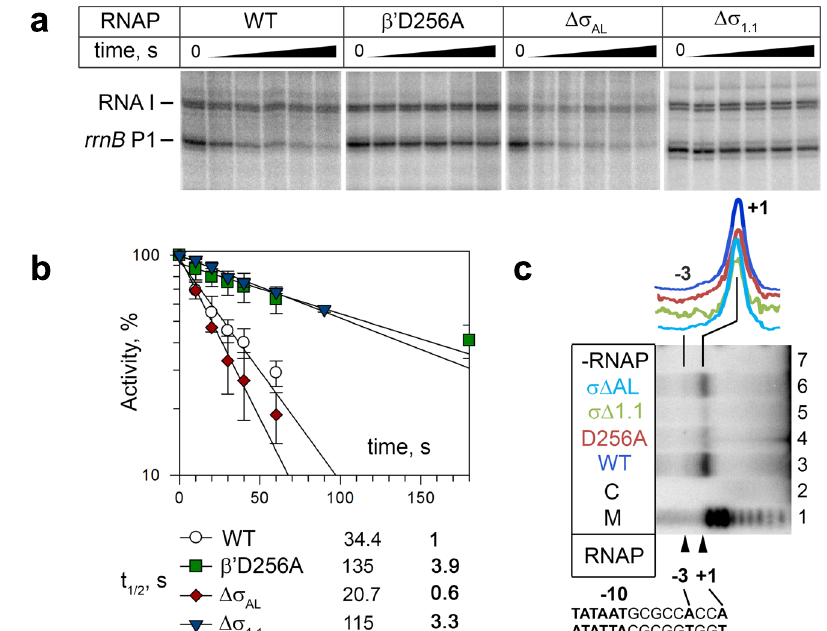
Fig. 3 Stabilities of rrnB P1 promoter complexes formed by wild-type and mutant RNAPs and their sensitivities against DksA/ppGpp. a Stabilities of rrnB P1 promoter complexes. Preformed complexes of E. coli RNAP with supercoiled plasmid DNA containing the rrnB P1 and RNAI promoters were incubated with competitor DNA (containing upstream fork-junction promoter DNA but lacking the TSS) for the indicated time intervals, followed by the addition of NTP substrates. Positions of the full-length transcripts are indicated. For each RNAP, the experiments were repeated independently two to fi ve times with similar results. b Kinetics of promoter complex dissociation for wild-type and mutant RNAPs. The half-lives of the promoter complexes for each RNAP are shown (measured in the absence of DksA; mean values from two to fi ve independent experiments). c Transcription start site mapping in rrnB P1 for wild- type and mutant RNAPs (a representative gel from two independent experiments). The products of in vitro transcription from rrnB P1 were used for primer extension with a 5 ′ -labeled downstream primer, and the lengths of the products were compared with the starting primer (lane 2) and size markers (lane 1). Lane 7 shows a control reaction performed in the absence of RNAP. Positions of the transcription start sites in the scrunched ( + 1) and relaxed ( − 3) promoter complexes are indicated. The scanned pro fi les of the primer extension products adjusted by the intensity of the main product for each RNAP are shown above the gel. Source data are provided as a Source Data fi